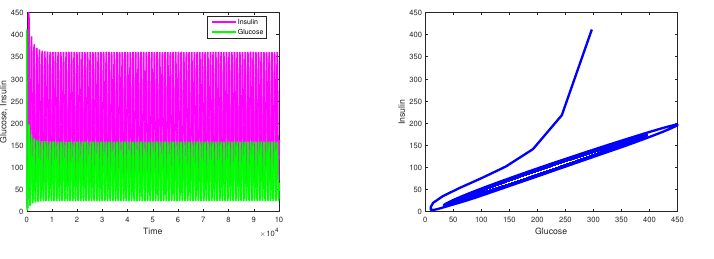
Figure 12. Glucose-insulin dynamics: dynamics and phase plain for τ g = 300 > τ ∗ g = 249